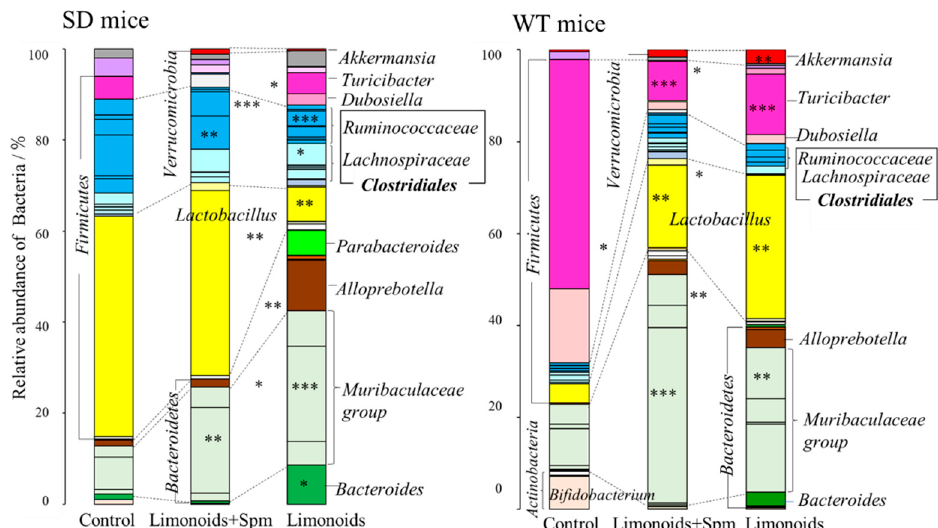
Figure 5. Estimated ratios (%) of taxonomic categories at the genus level were identified according to genomic analysis of 16S rRNA in the feces of SD or WT mice aged 12–14 weeks (WT mice; n = 9/each group, SD mice; n = 15/each group). Values represent means ± S.D. Data onto a bar graph are plotted in comparison to the controls for clarity; * p ≤ 0.05; ** p ≤ 0.01; *** p ≤ 0.001. SD, Sandhoff disease; WT, wild-type. Table 1. Comparison of the relative abundance of bacterial (%) in feces from SD or WT mice fed with a normal diet (con- trol), limonoids + Spm or limonoids alone.